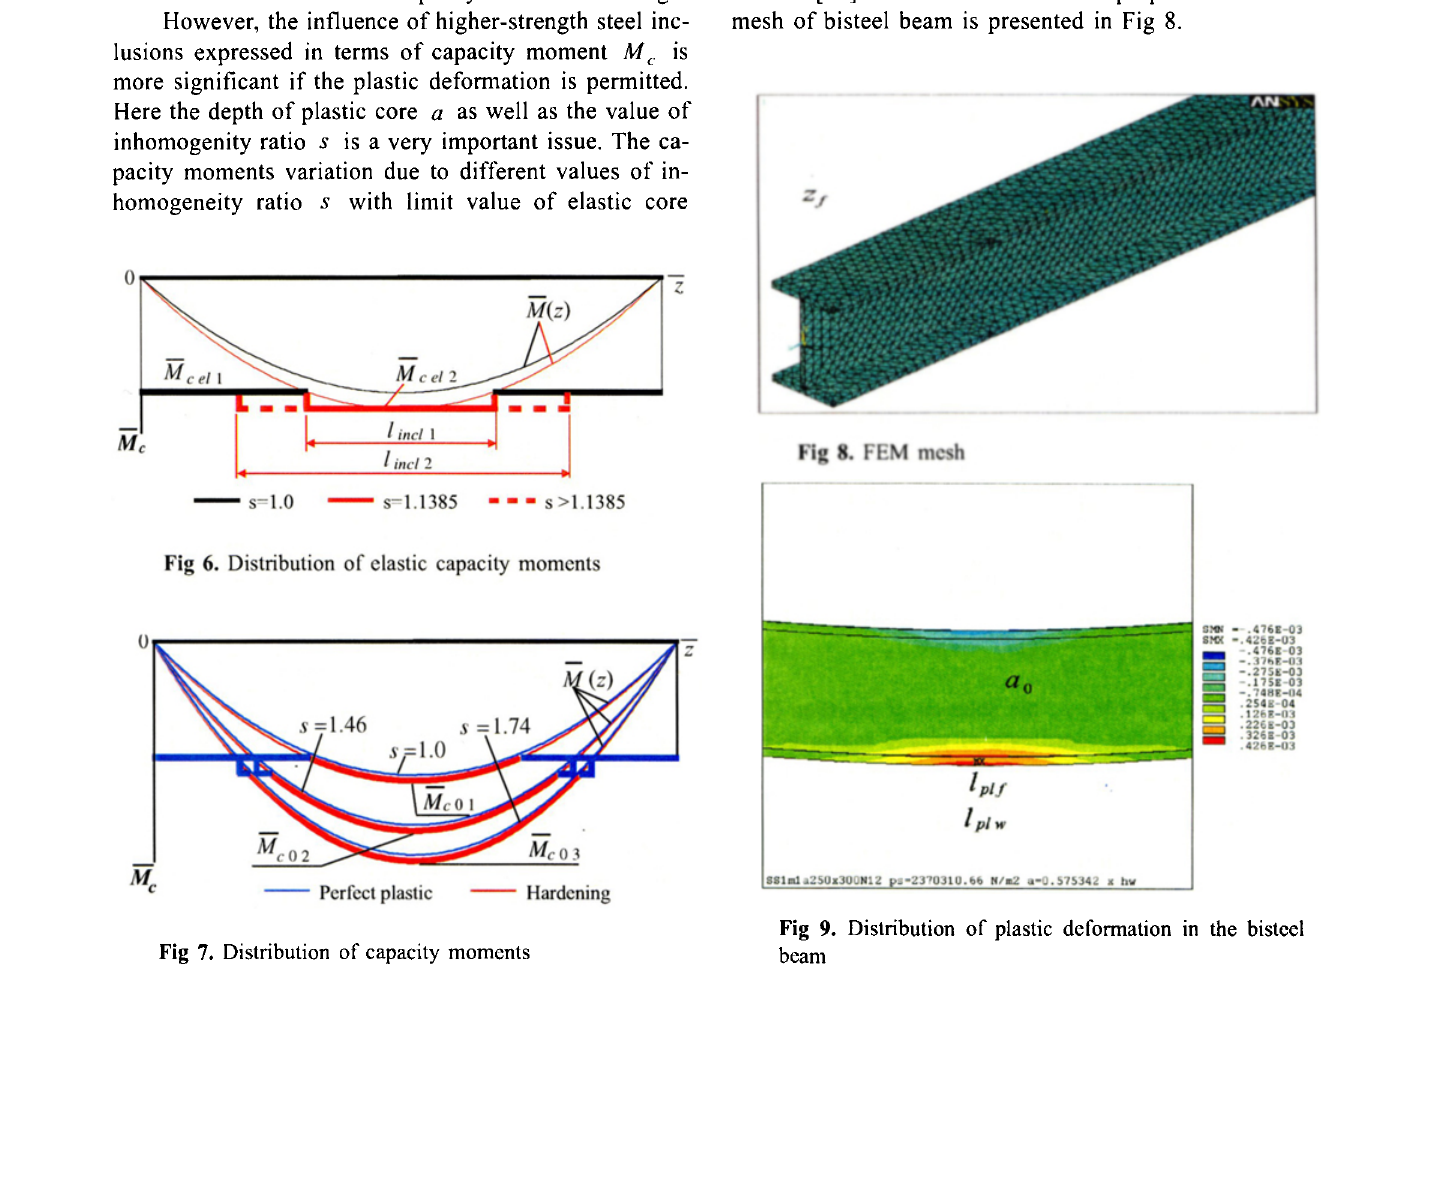
Fig 7. Distribution of capacity moments